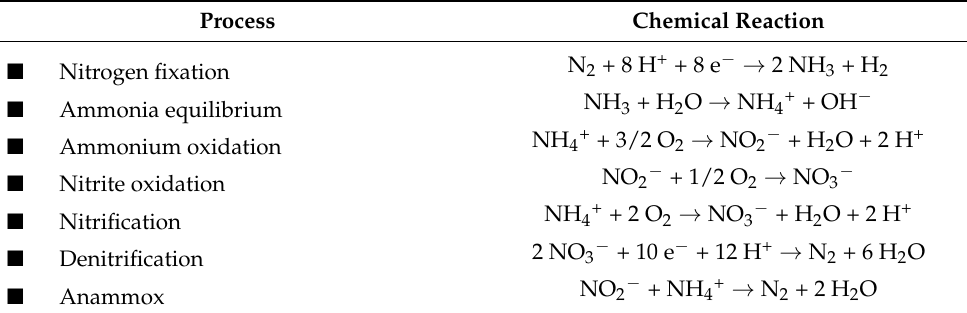
Figure 1. The biological nitrogen cycle. Table 1. Chemical reactions in the nitrogen